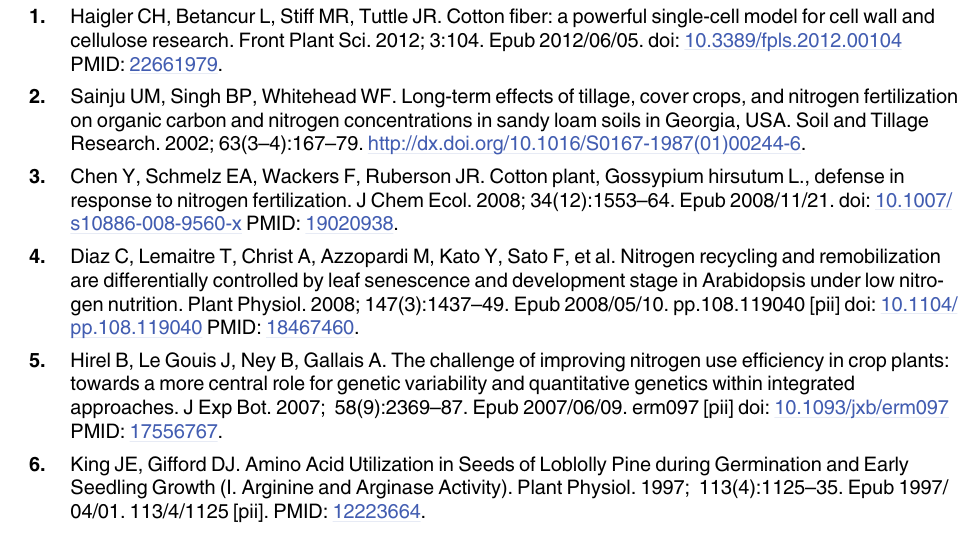
S2 Table. Average fiber length of transgenic cotton in different